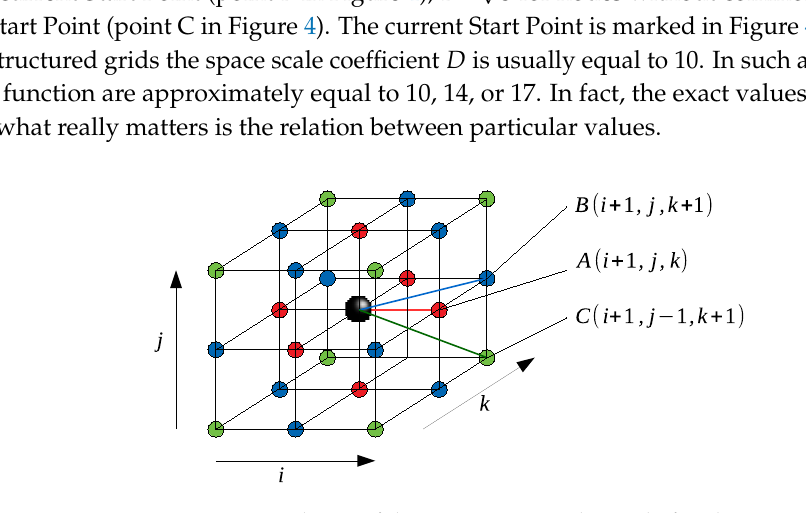
Figure 4. A schema of directions in a regular grid of